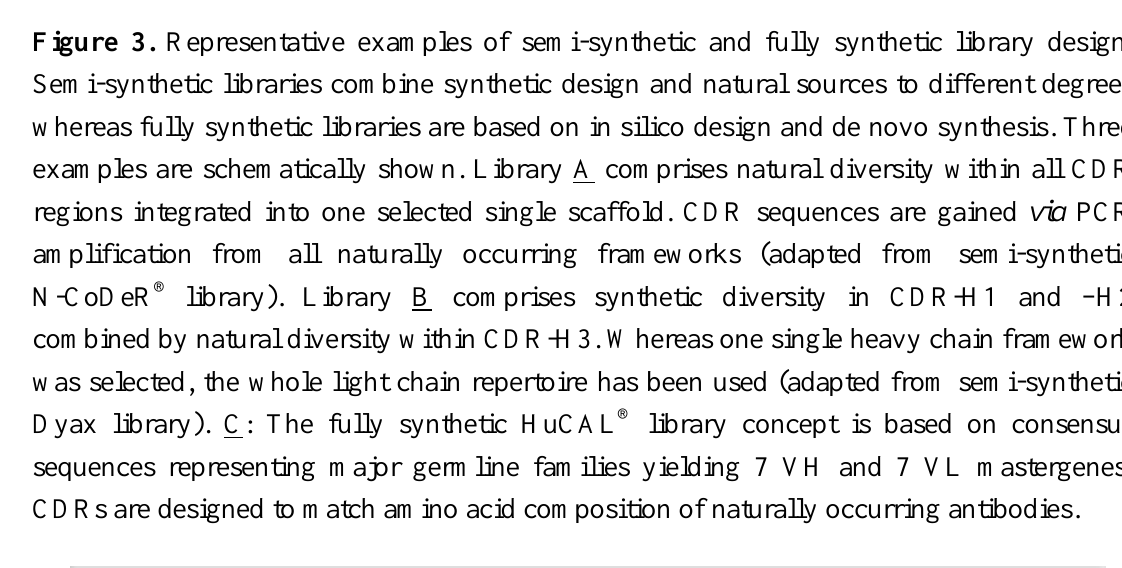
Figure 3. Representative examples of semi-synthetic and fully synthetic library design. Semi-synthetic libraries combine synthetic design and natural sources to different